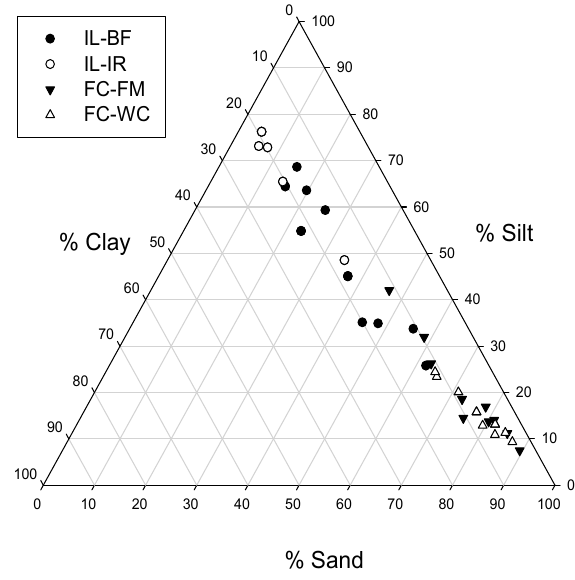
Figure 2. Soil texture of streambank soil samples collected at field data collection sites along Barron Fork Creek (IL-BF), Illinois River (IL-IR), Fivemile Creek (FC-FM) and Willow Creek (FC-WC).